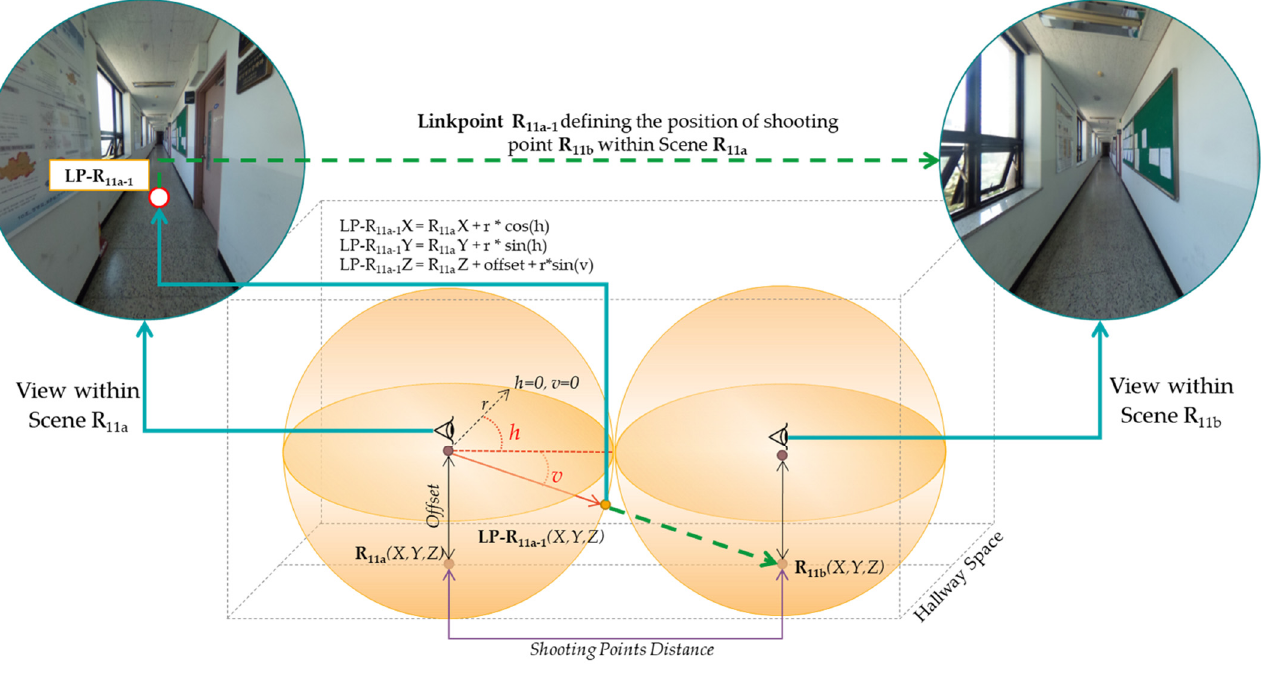
Figure 6. Implementing the positioning of indoor spaces through linkpoints in the omnidirectional image.